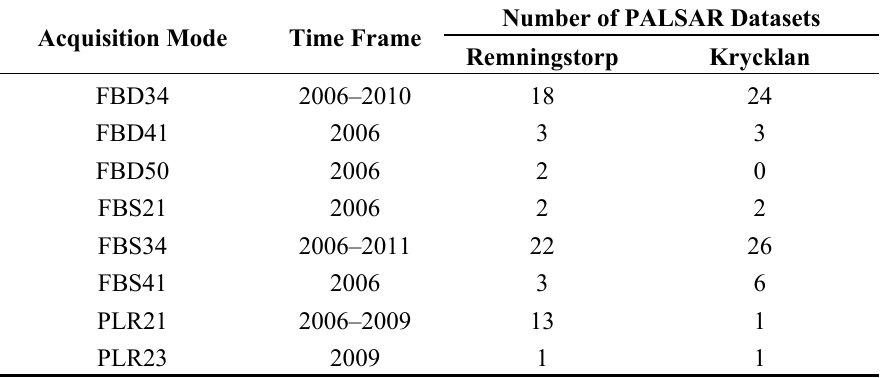
Table 2. Number of PALSAR datasets available over Remningstorp and Krycklan grouped according to acquisition mode. Each dataset acquired in the FBS, FBD and PLR mode consisted of 1, 2 and 4 images, respectively.